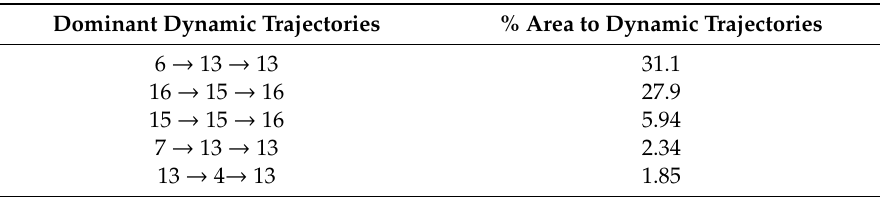
Table 3. The major dynamic